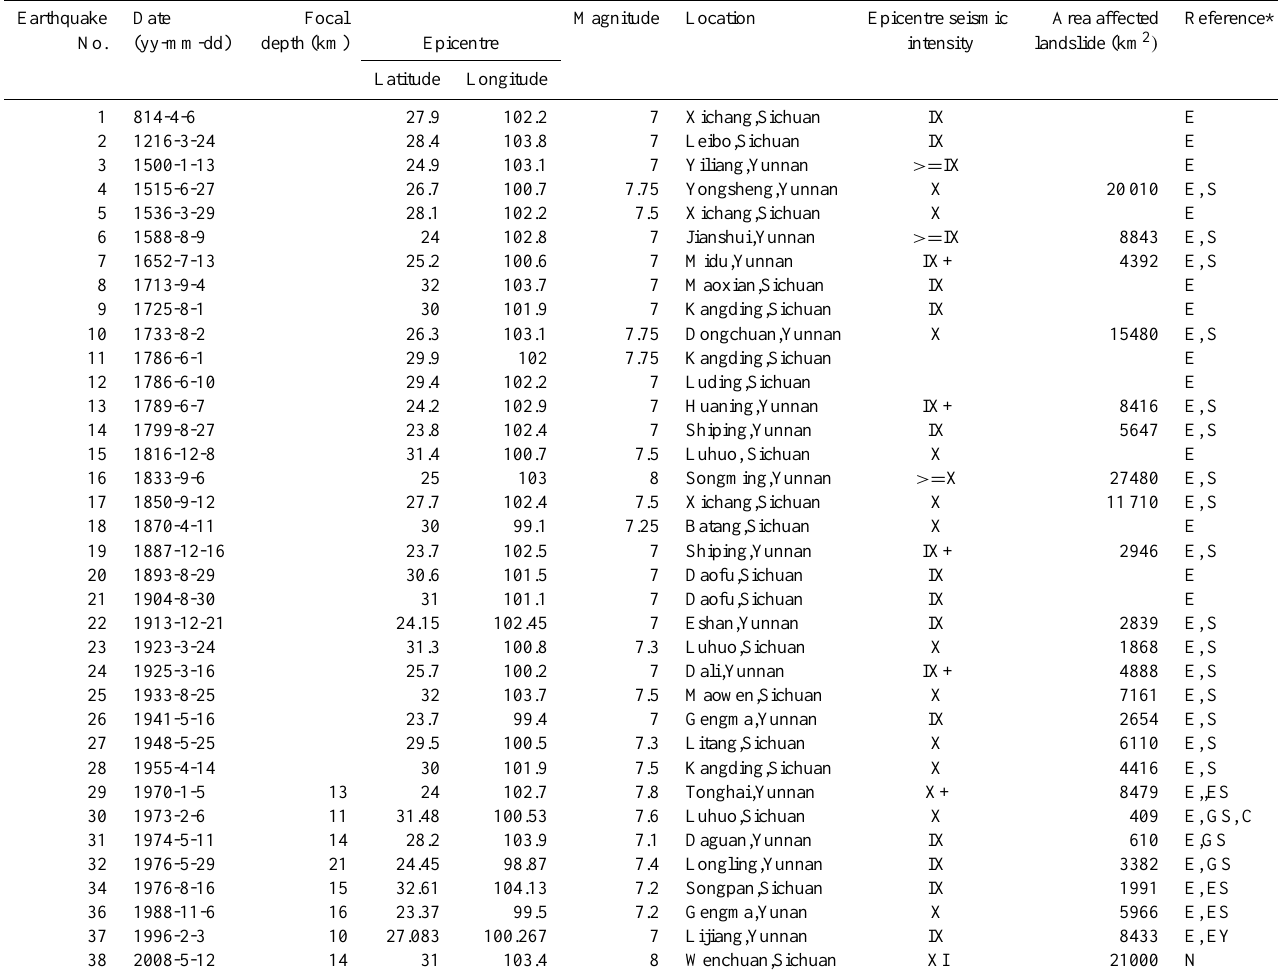
Table 1. Earthquakes with magnitude 7.0 or greater in southwest China.